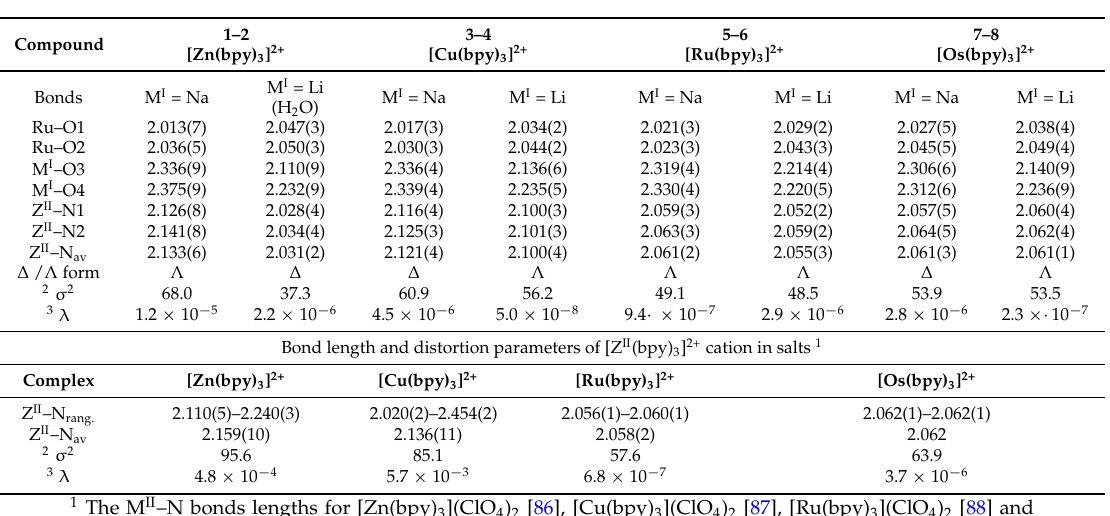
Table 1. Selected bond length (Å) for {[Z II (bpy) 3 ][NaRu(C 2 O 4 ) 3 ]} n (Z II = Zn 2+ ( 1 ), Cu 2+ ( 3 ), Ru 2+ ( 5 ), Os 2+ ( 7 )), {[Zn II (bpy) 3 ](H 2 O)[LiRu(C 2 O 4 ) 3 ]} n ( 2 ) and [Z II (bpy) 3 ][LiRu(C 2 O 4 ) 3 ]} n (Z II = Cu 2+ ( 4 ), Ru 2+ ( 6 ), Os 2+ ( 8 )) coordination polymers; the configuration and structural distortion parameters of [Z II (bpy) 3 ] 2+ (Z II = Zn 2+ , Cu 2+ , Ru 2+ , Os 2+ ) guests compared to the corresponding [Z II (bpy) 3 ] 2+ cation